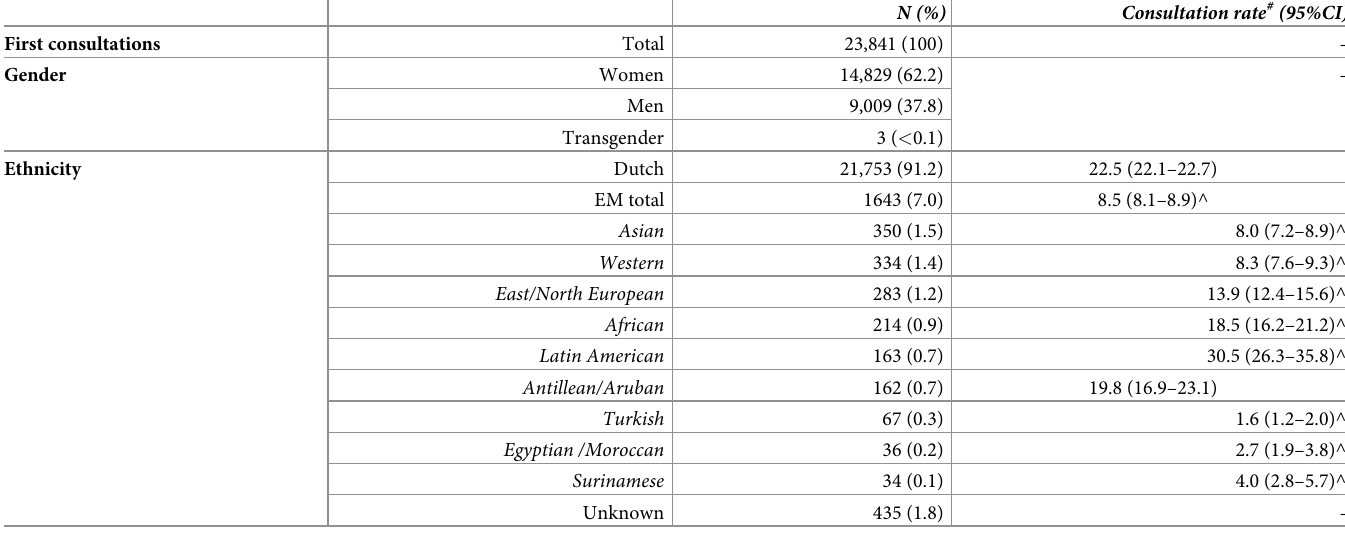
Table 1. Demographic characteristics of 23,841 clients visiting an STI clinic in the eastern part of the Netherlands in 2011–2013 and consultation rates per 1000 person years by